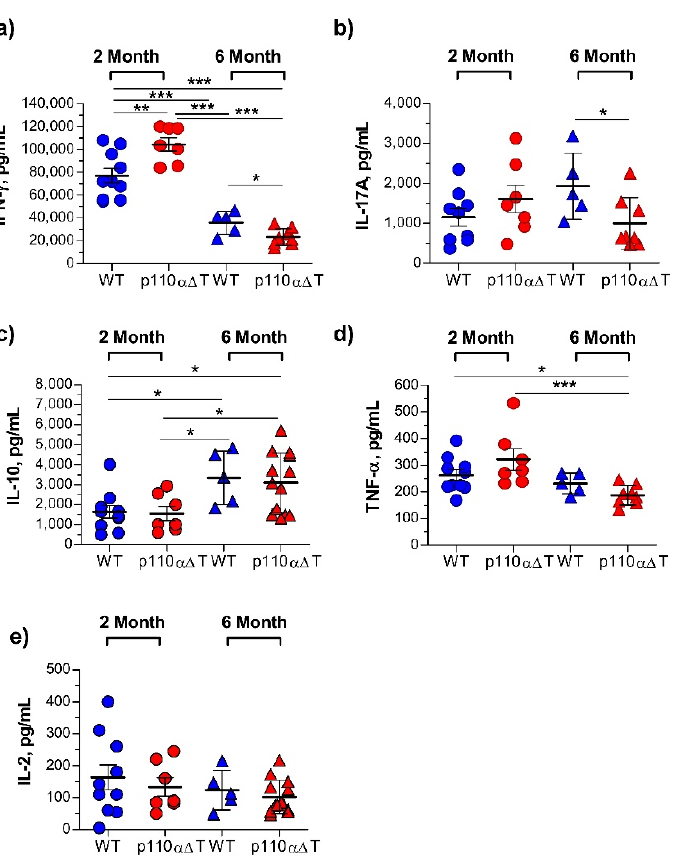
Figure 3. Cytokine secretion by lymph node cells from young and mature wild type (WT) or p110 α ∆ T mice undergoing Experimental Allergic Encephalomyelitis (EAE). Lymph node cells from individual mice surviving on day 28 after Myelin Oligodendrocyte Glycoprotein (MOG) immunization were cultured for 96 h in the presence of MOG peptide antigen. Then, cytokine content in the supernatants was determined, as follows: ( a ) IFN- γ ; ( b ) IL-17A; ( c ) IL-10; ( d ) TNF- α ; ( e ) IL-2. Data from two different experiments each of young and mature mice; individual data from young WT ( n = 10, blue circles), young p110 αΔ T ( n = 7, red circles), mature WT ( n = 5, blue triangles), and mature p110 αΔ T mice ( n = 8, red triangles) are shown. Significant differences between groups are indicated, as determined by One-way ANOVA (* p < 0.05, ** p < 0.01, *** p < 0.001).